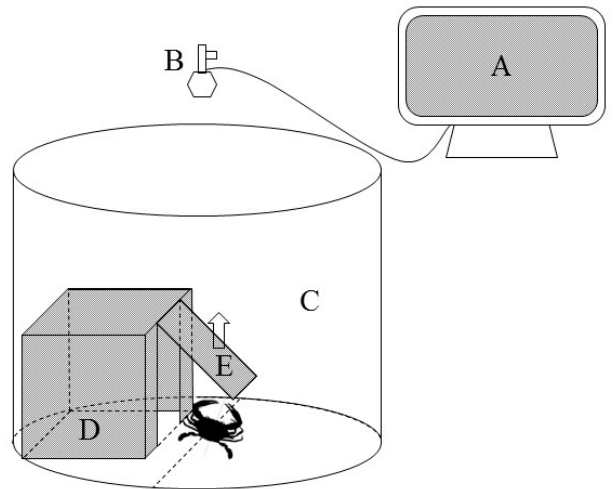
Figure 1. Observation system used to record personality behaviors. Note: ( A ) monitor, ( B ) camera, ( C ) observation box, ( D ) shelter (length × width × height: 30 × 20 × 20 cm), ( E ) trapdoor (length × width: 20 × 20 cm).